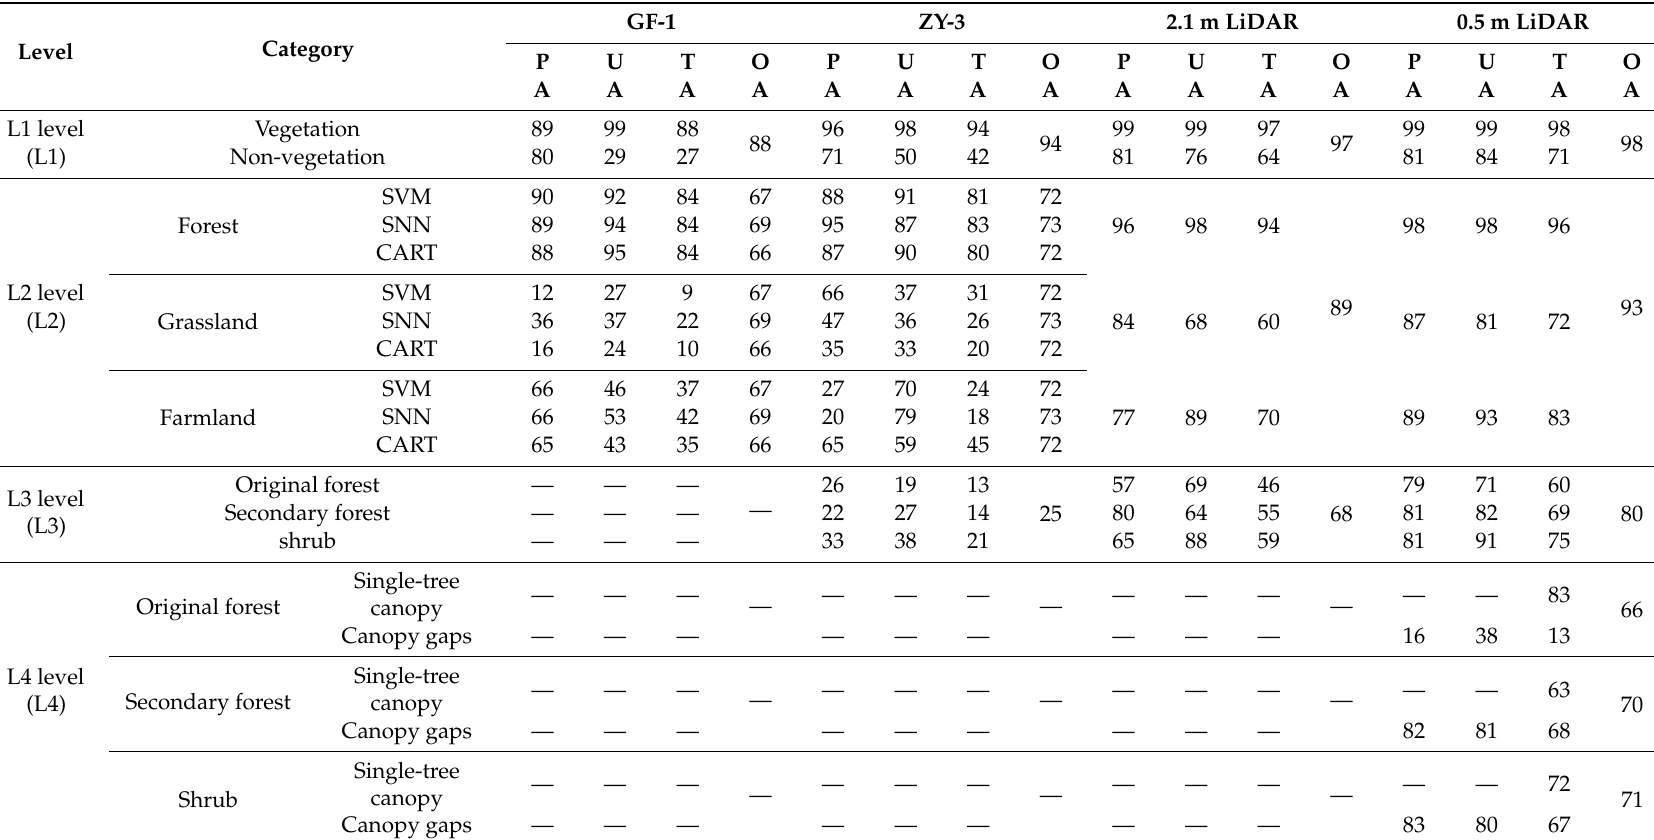
Table 3. Statistical summary of hierarchical classification accuracy data based on area (unit: